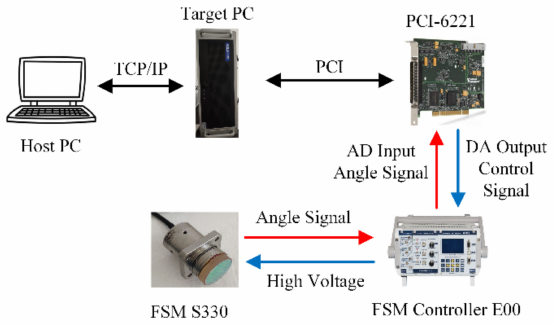
Figure 11. Experiment platform.